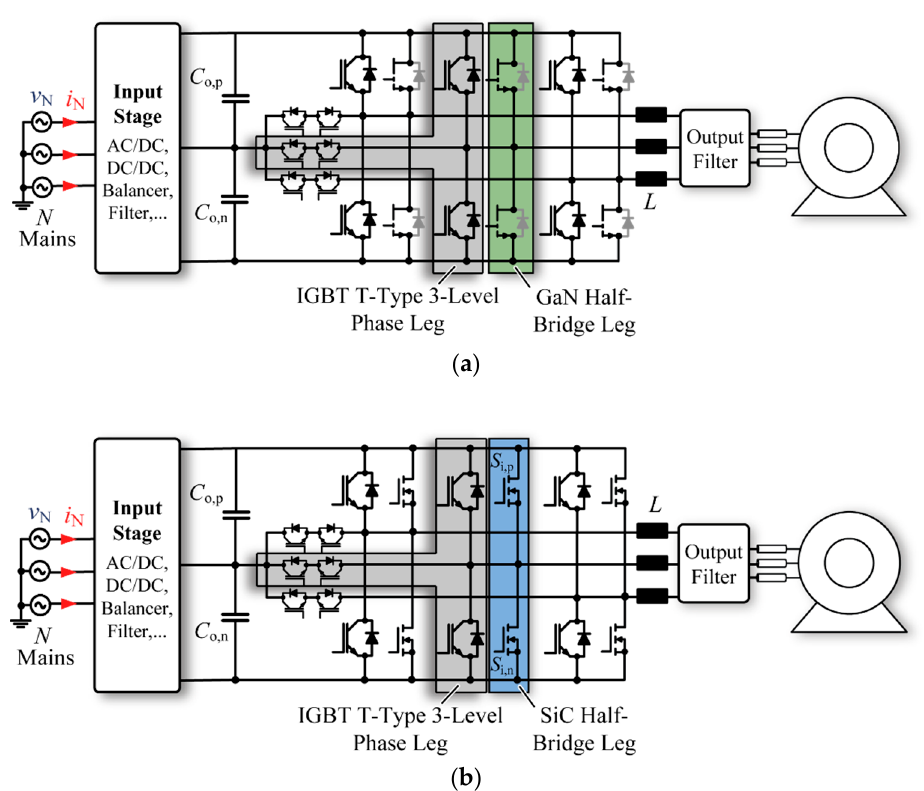
Figure 3. Three-phase IGBT-based t-type drive system with either ( a ) GaN half-bridge stages for 400 V DC or ( b ) SiC half-bridge stages for 800-V DC DC-link voltage levels.